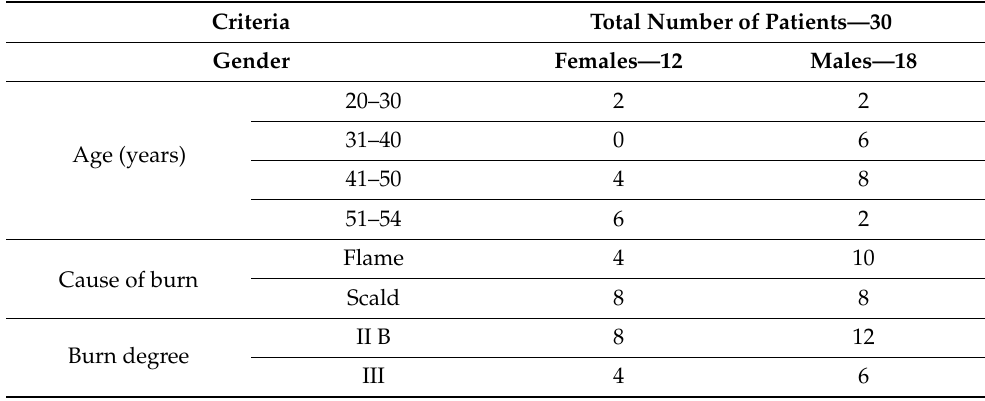
Table 1. Demographics and burn wound characteristics of patients included in the